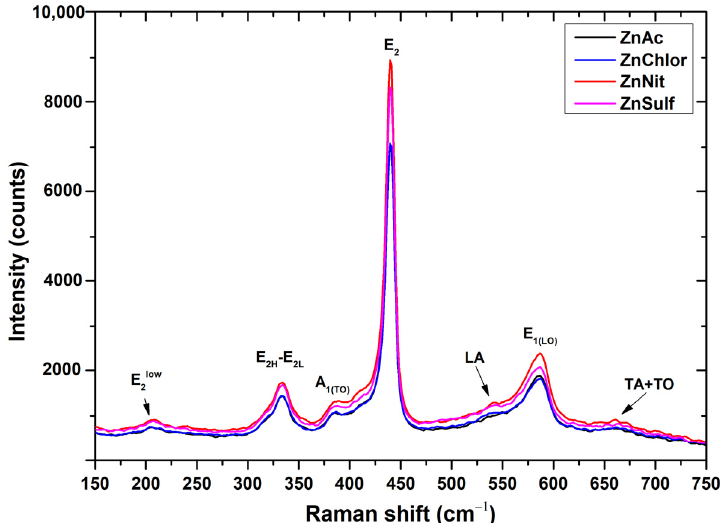
Figure 3. Raman spectra of ZnO nanoparticles, synthesized using as precursor zinc acetate dehydrate (in black) (ZnAc), zinc chloride (in blue) (ZnChlor), zinc nitrate hexahydrate (in red) (ZnNit), and zinc sulphate heptahydrate (in purple) (ZnSulf).